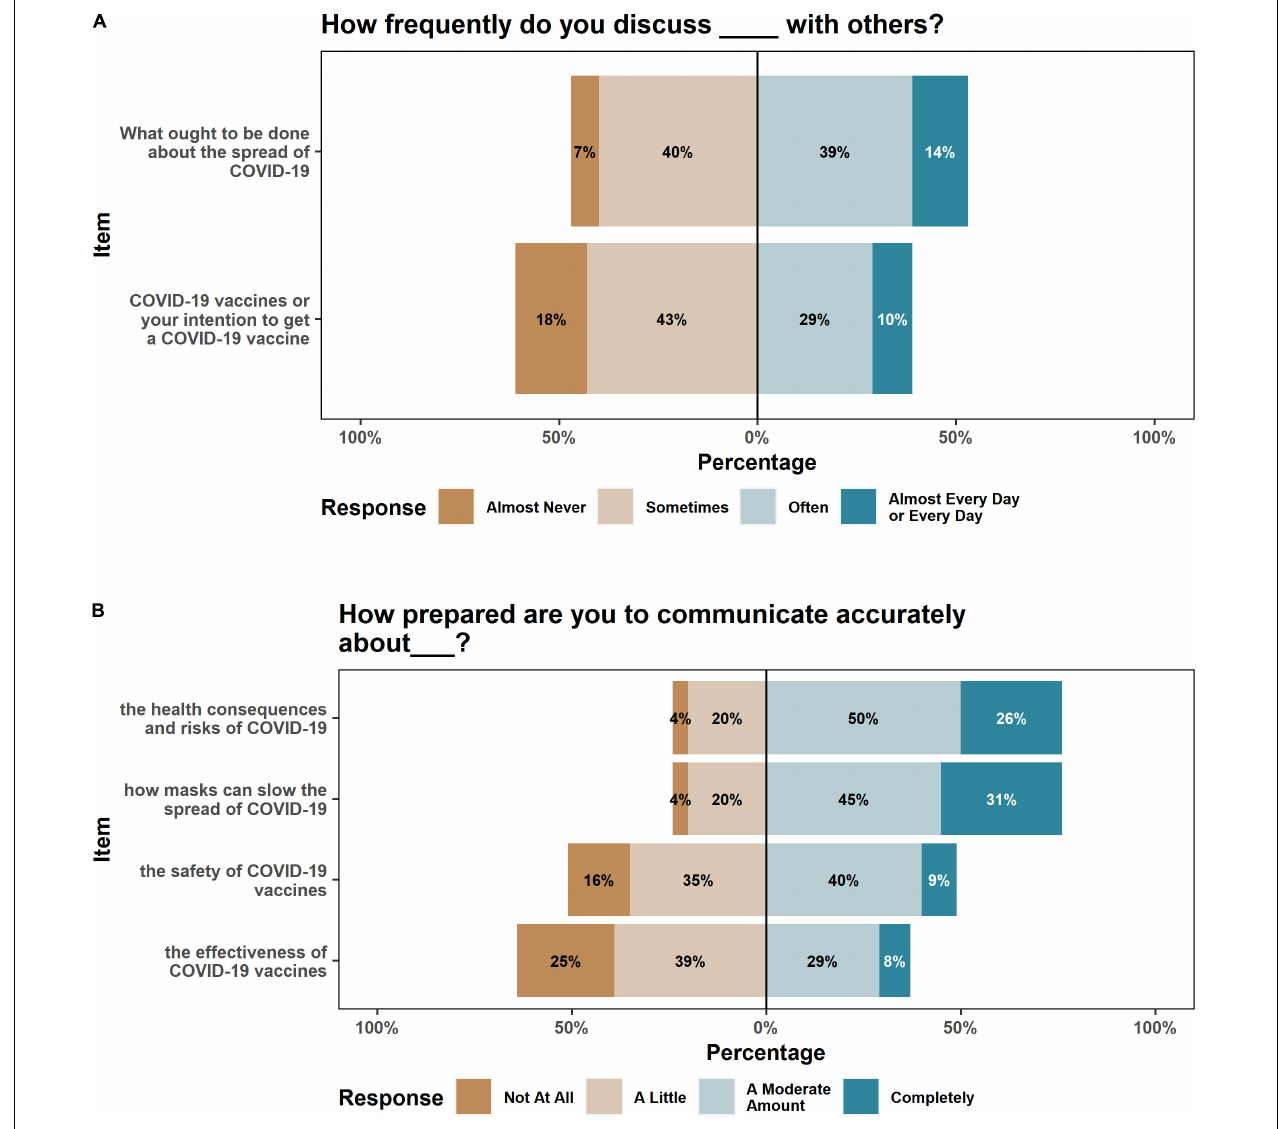
FIGURE 1 | Horizontal stacked bar graphs representing (A) how frequently students discuss COVID-19 with others and (B) how prepared students are to communicate about COVID-19 accurately. n =